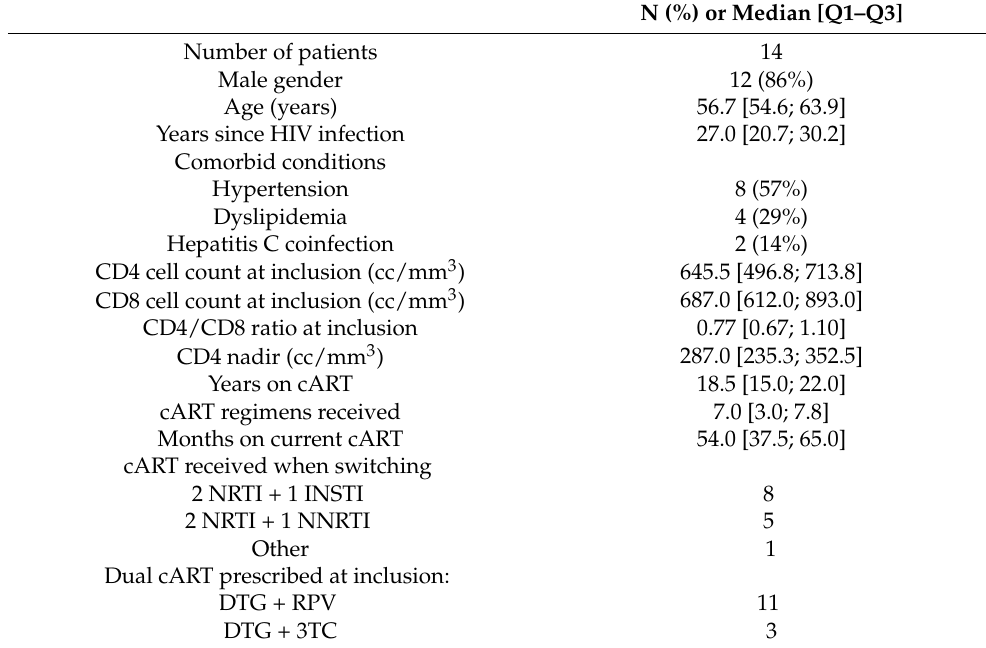
Table 1. Characteristics of patients included.